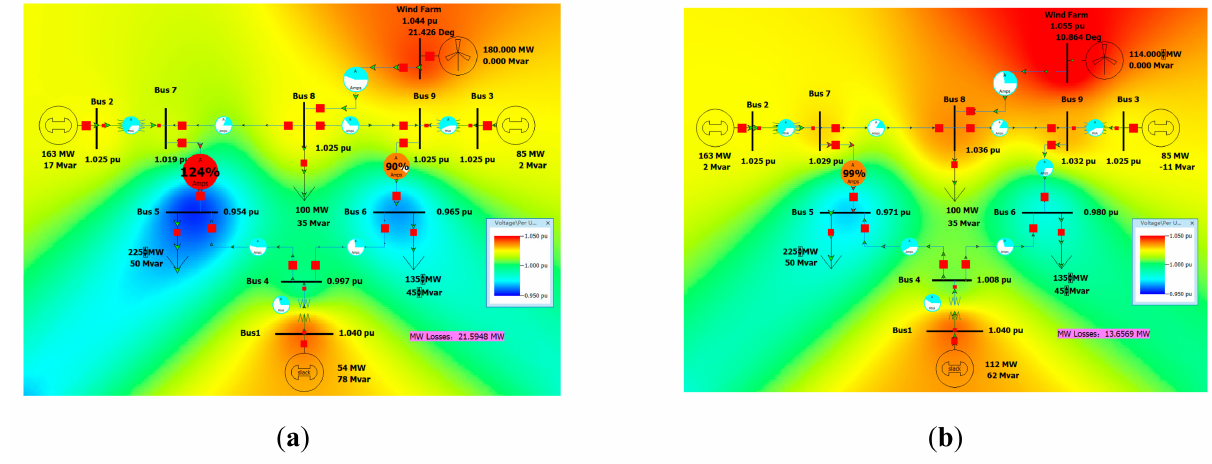
Figure 11. Simulation results of the maximum load of tower A connected to bus No. 8 (150 km). ( a ) Maximum load condition, ( b ) Maximum load condition with reducing Wind Farm output. (2) Simulation of tower B connected to bus 8